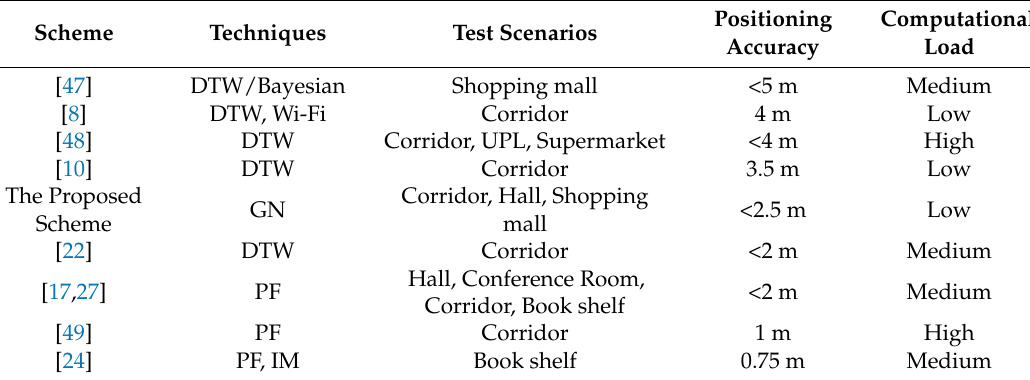
Table 2. Performance comparison of the proposed method with the current